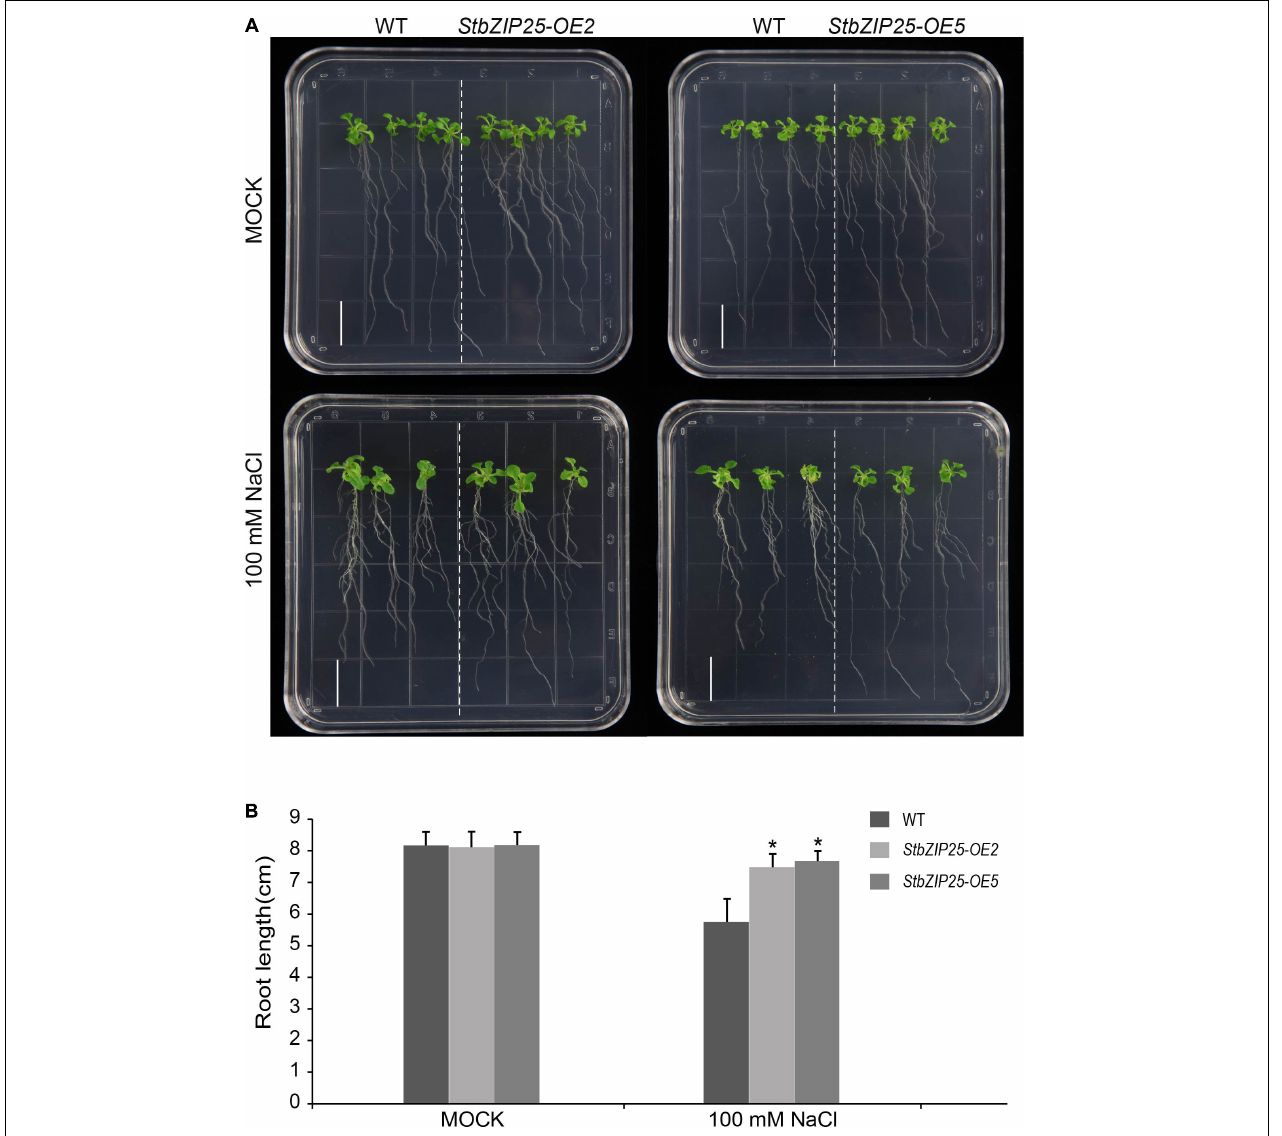
FIGURE 10 | Effects of salt stress treatments on the root growth of the StbZIP25 gene overexpressed in Arabidopsis . (A) Primary root lengths of the wild-type and StbZIP25 overexpression lines under salt treatments in transgenic Arabidopsis . (B) Quantification of the primary root lengths under normal condition and 100 mM NaCl treatments. Bar , 1.5 cm. The data were retrieved from three biological replicates. WT, wild type. Data are the mean ± SD of three biological repeats. * p < 0.05 ( t